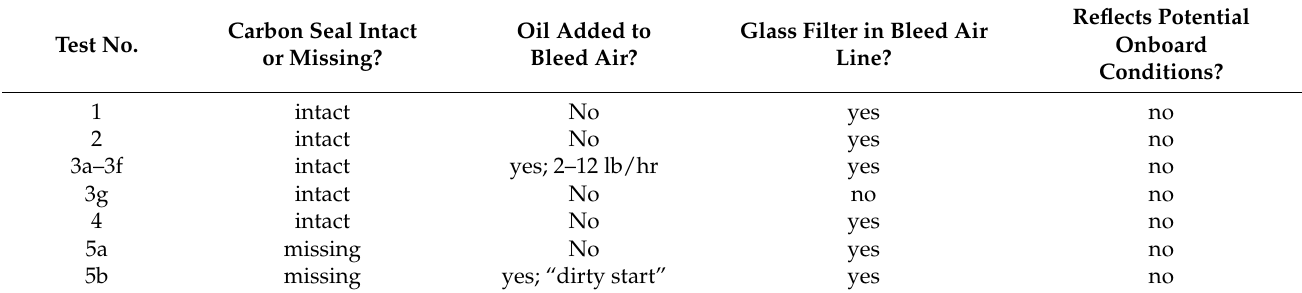
Table 3. Key features of engine bleed testing, per the NTSB investigative report [16].